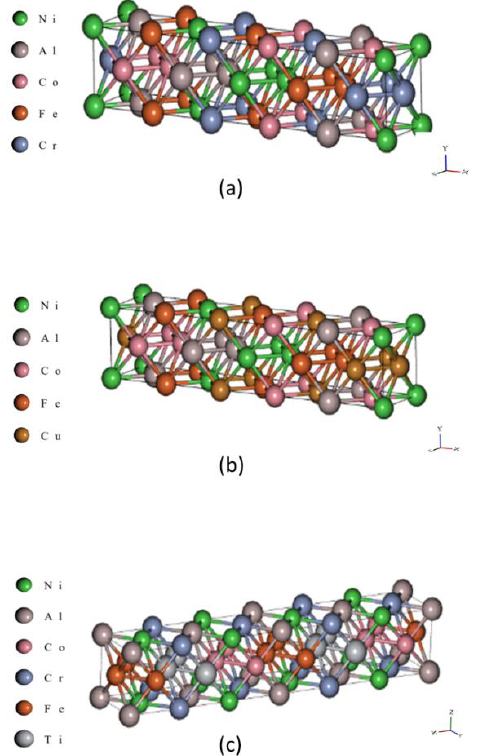
Figure A6. Deformed HEA geometries for the calculation of elastic constants in ( a ) AlCoCrFeNi, ( b ) AlCoCuFeNi and ( c ) AlCoCrFeNiTi.